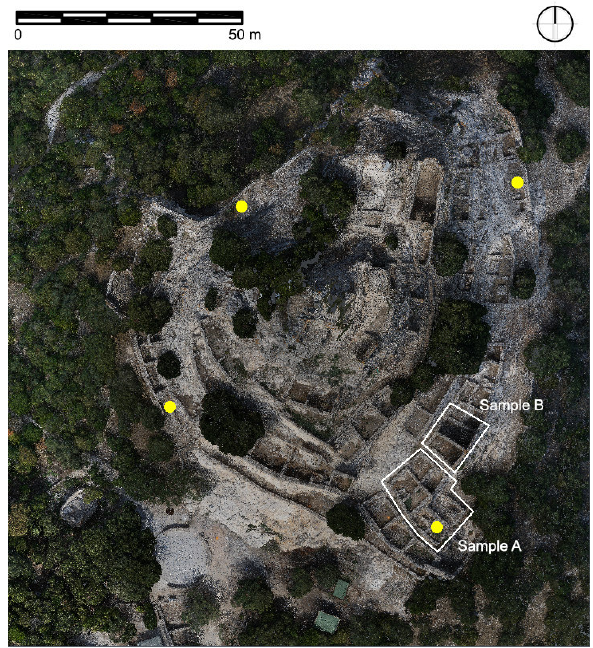
Figure 4. Position of the two selected samples and of the 4 GCPs (in yellow) used to evaluate the impact of the different configuration on the initial processing of the projects Sample A encloses different residential blocks developed in two levels and their internal road system; the walls preserved are not really high, but are close to each other and the urbanistic system is quite dense in this part of the site. Sample B cover another building of the medieval village where part of the structures is really well preserved; an entire façade is preserved from the Table 2. RMSs (mean) of the check points (CPs) used to ground till the ancient roof support (Figure evaluate the impact of camera and flight configuration on the accuracy of the bundle block adjustment